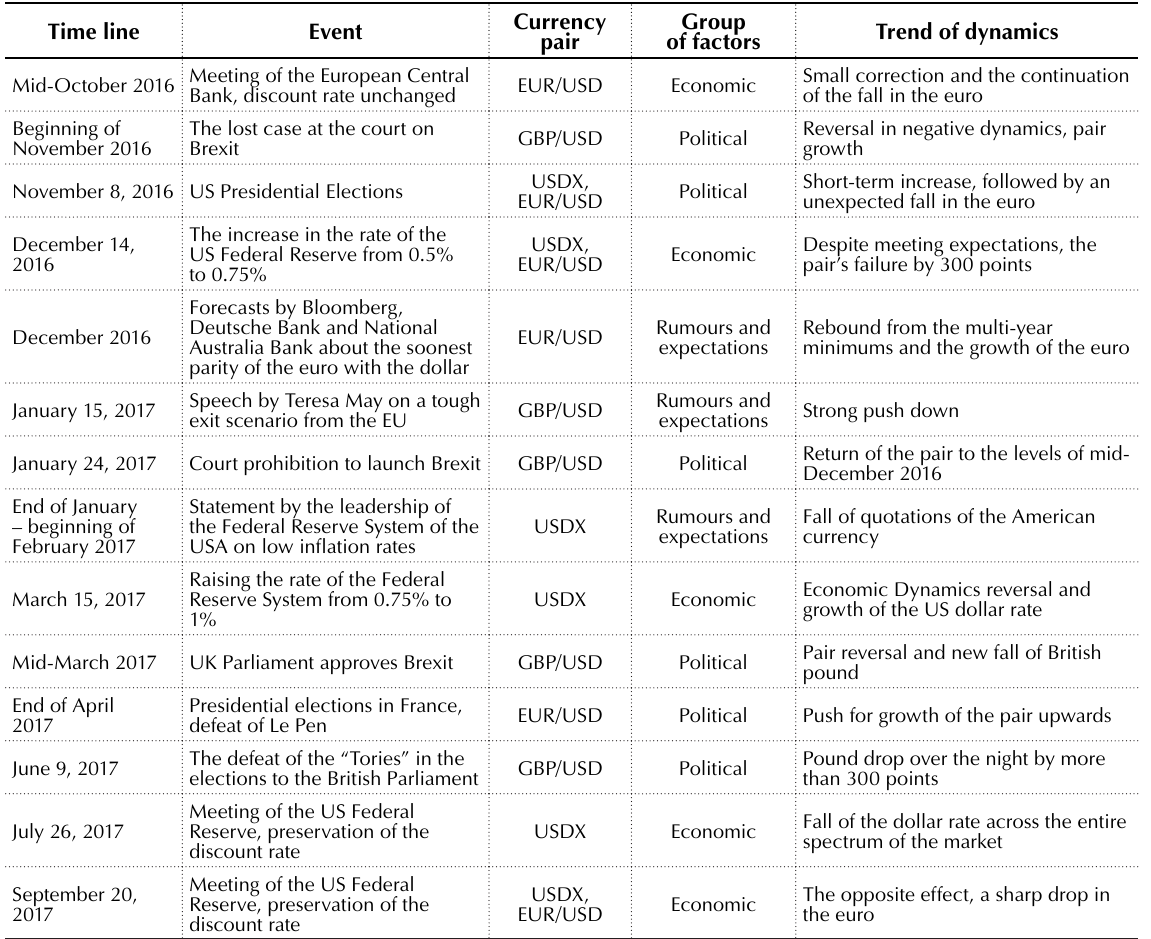
Table 1. Cases of currency fluctuations that are not amenable to technical analysis, divided by groups of fundamental analysis